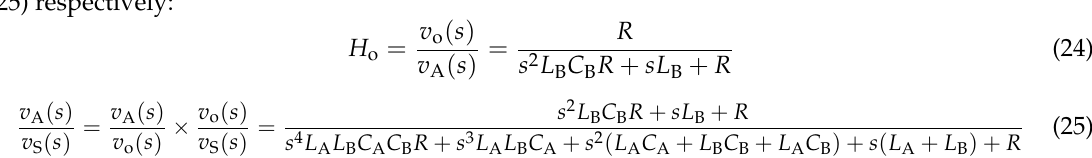
Figure 6. Prototype of GaN class-D amplifier ( a ) top-side ( b ) bottom side.